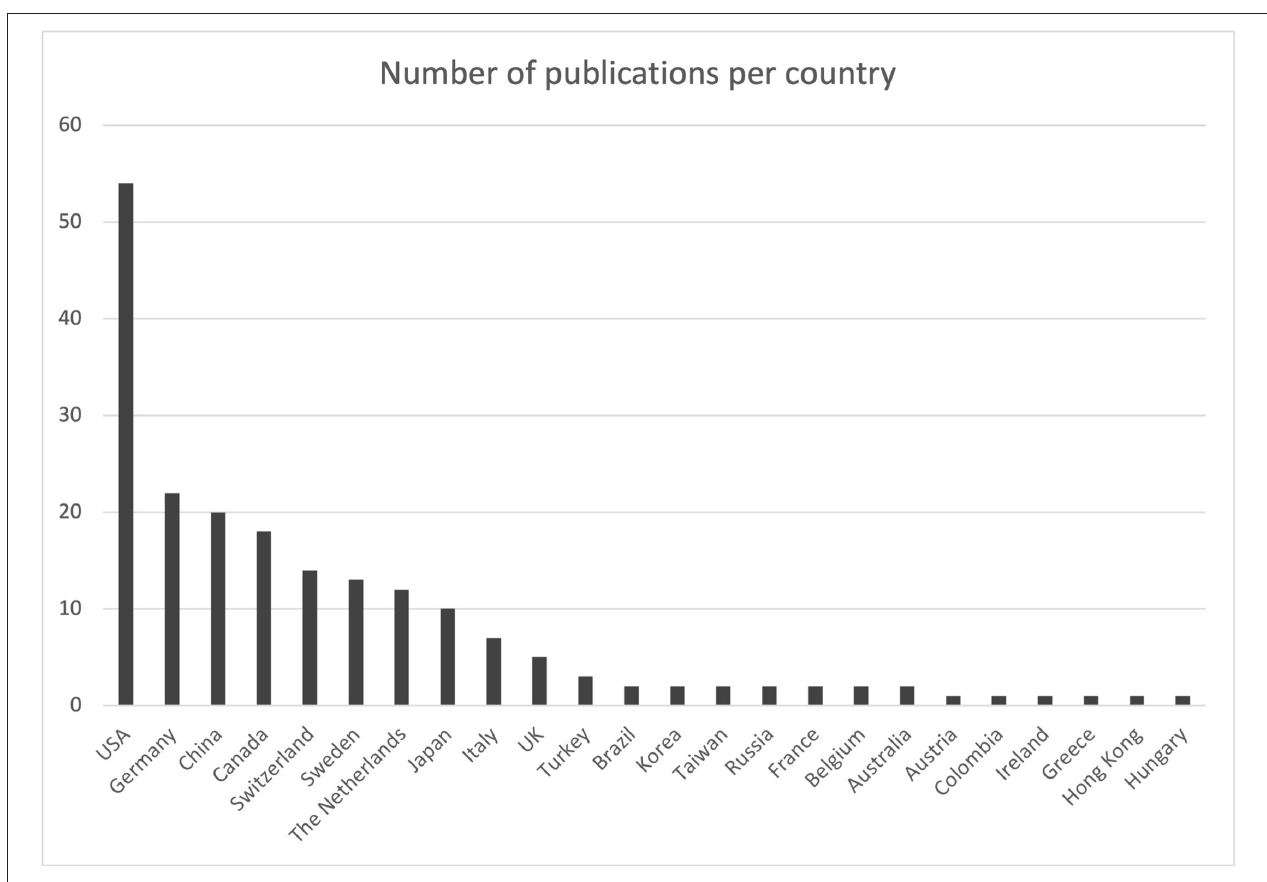
FIGURE 4 | Diagram representing the number of publications per